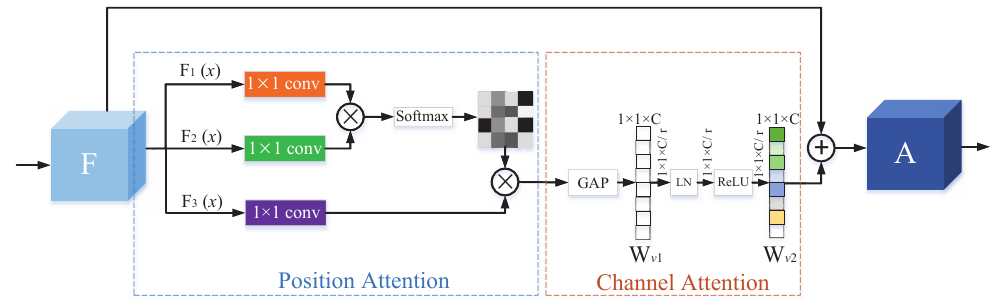
Figure 6. The overview of attention layer (part of the multi-layer attention network). The ⊕ denotes the broadcast element-wise